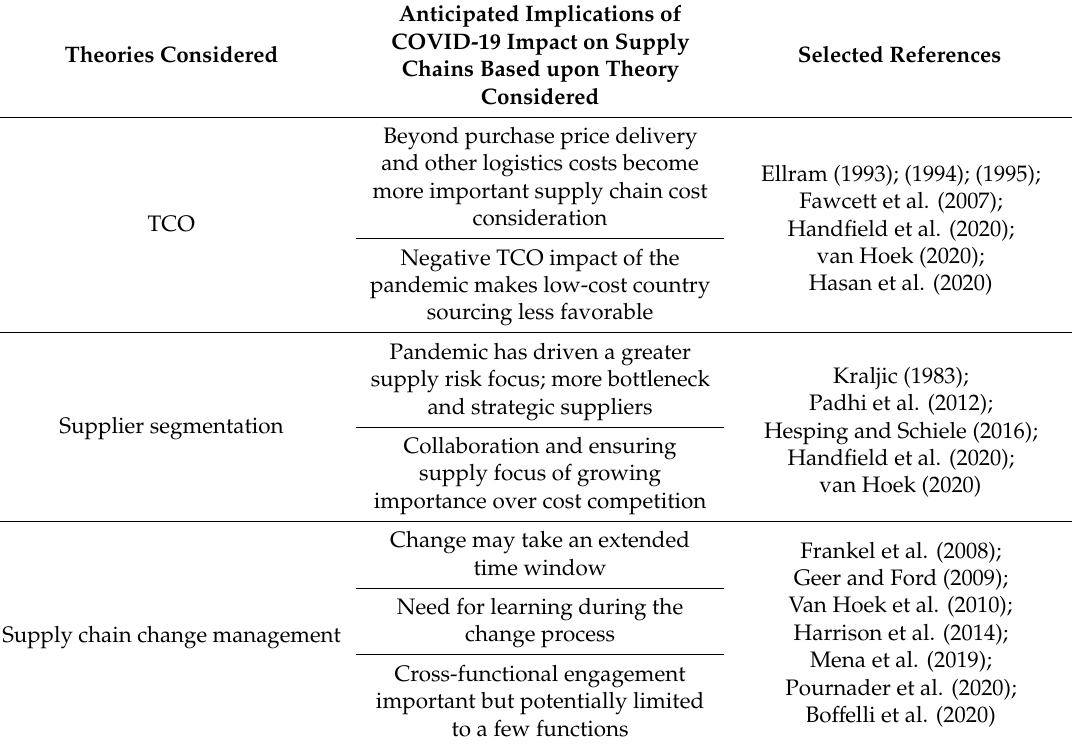
Table 1. Anticipated impact of COVID-19 on supply chain based upon theories